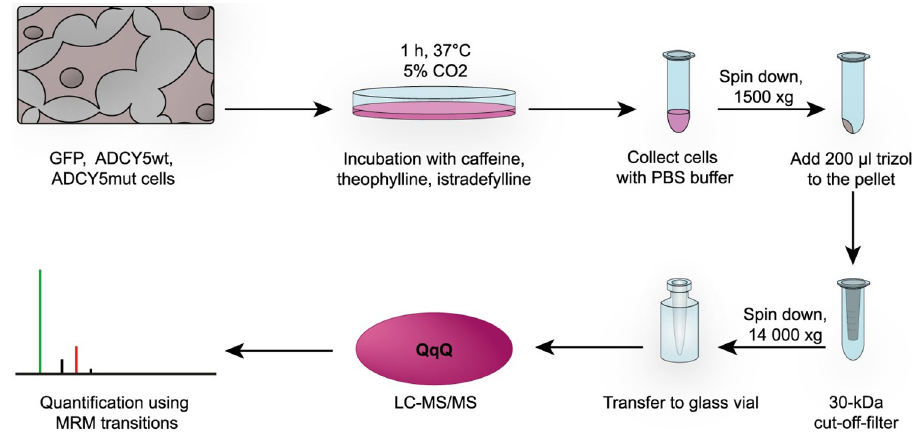
Fig 2. Analytical